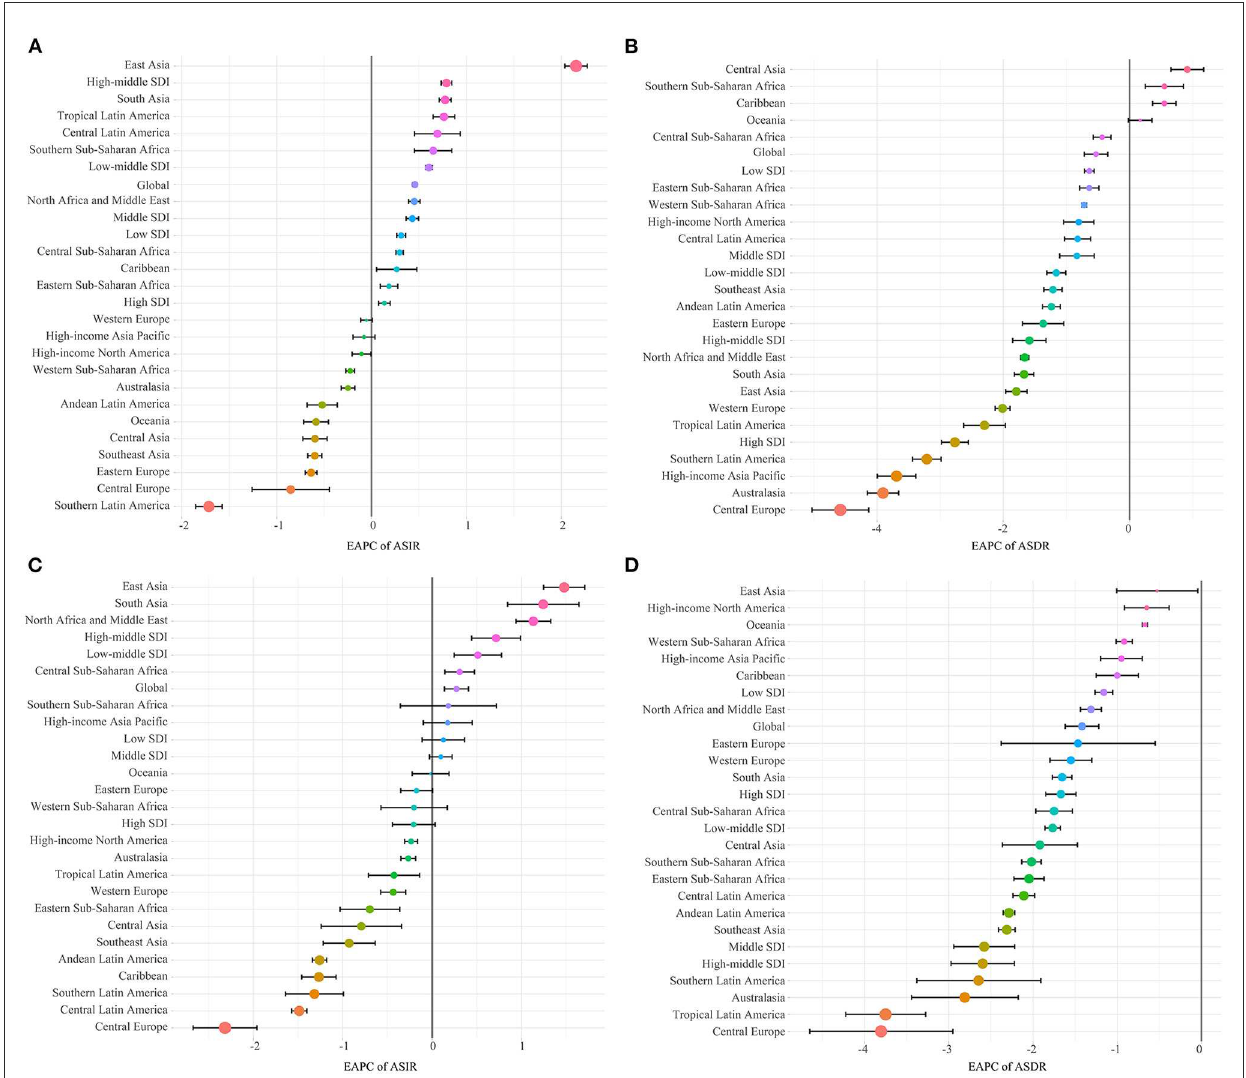
FIGURE2 Estimated annual percentage changes (EAPCs) of ASIRs and ASDRs in NSNIs at the regional levels. (A) EAPCs of ASIRs from 1990 to 2019; (B) EAPCs of ASDRs from 1990 to 2019; (C) EAPCs of ASIRs from 2010 to 2019; (D) EAPCs of ASDRs from 2010 to